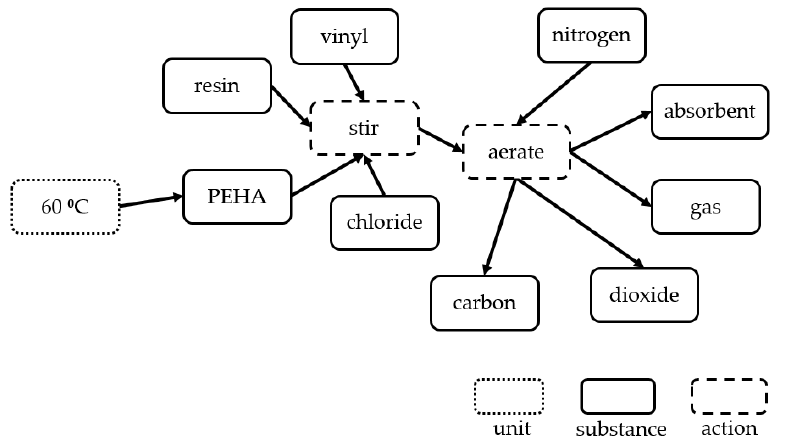
Figure 6. Process graph of US10722838B2.